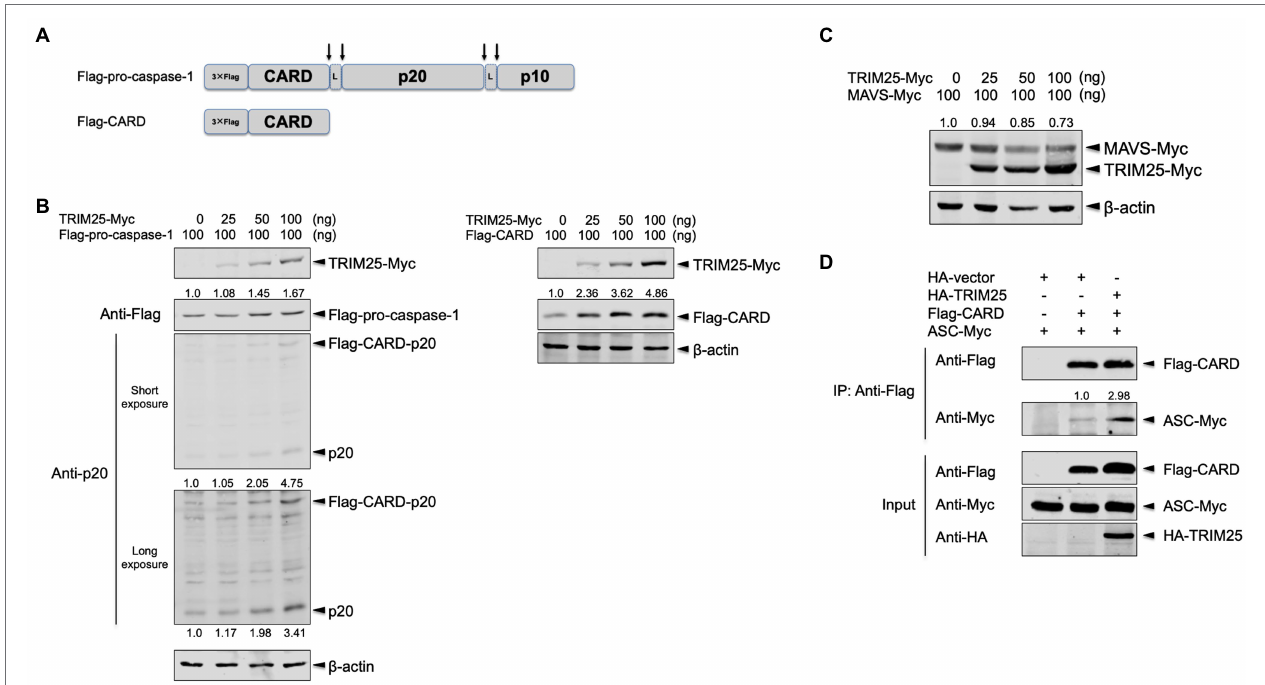
FIGURE 2 | TRIM25 promotes the interaction between pro-caspase-1 caspase activation and recruitment domain (CARD) and ASC. (A) Domain architectures of 3× Flag-tagged full-length porcine pro-caspase-1 expressed by the Flag-pro-caspase-1 construct and 3× Flag-tagged porcine pro-caspase-1 CARD expressed by the Flag-CARD construct. Pro-caspase-1 CARD interacts with ASC for inflammasome activation. Upon cleavage on the sites indicated by arrows, active subunits (p20 and p10) are generated. The linker regions are denoted by L. (B) HEK293T cells were transfected with a plasmid expressing Flag-tagged porcine pro- caspase-1 (left panel) or Flag-tagged porcine pro-caspase-1 CARD (right panel) along with increasing amounts of a plasmid expressing Myc-tagged porcine TRIM25 for 16 h. The expression of Myc-tagged TRIM25, Flag-tagged pro-caspase-1, Flag-tagged CARD-p20 fragment, p20 and Flag-tagged CARD was analyzed by Western blotting. Relative intensities of Flag-pro-caspase-1 (left panel) or Flag-CARD (right panel) to that without TRIM25-Myc were shown above each band. Relative intensities of Flag-CARD-p20 and p20 were shown above and below each band, respectively, on the long-exposure image (left panel). (C) HEK293T cells were transfected with a plasmid expressing Myc-tagged porcine mitochondrial antiviral signaling protein (MAVS) along with increasing amounts of a plasmid expressing Myc-tagged porcine TRIM25 for 16 h. The expression of Myc-tagged MAVS and TRIM25 was analyzed by Western blotting. Relative intensities of MAVS- Myc to that in sample without TRIM25-Myc were shown above each band. (D) HEK293T cells were transfected with plasmids expressing Flag-tagged porcine pro- caspase-1 CARD and Myc-tagged porcine ASC along with either an empty HA-vector or a plasmid expressing HA-tagged porcine TRIM25 for 24 h. Cell lysates were subjected to IP with anti-Flag antibody. The expression of Flag-tagged CARD, Myc-tagged ASC and HA-tagged TRIM25 in IP and input samples was analyzed by Western blotting using antibodies indicated. A relative intensity of ASC-Myc to that in sample without HA-TRIM25 was shown above each band. Results are representative of three independent